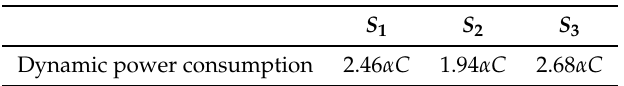
Table 4. Dynamic power consumption of some feasible processor